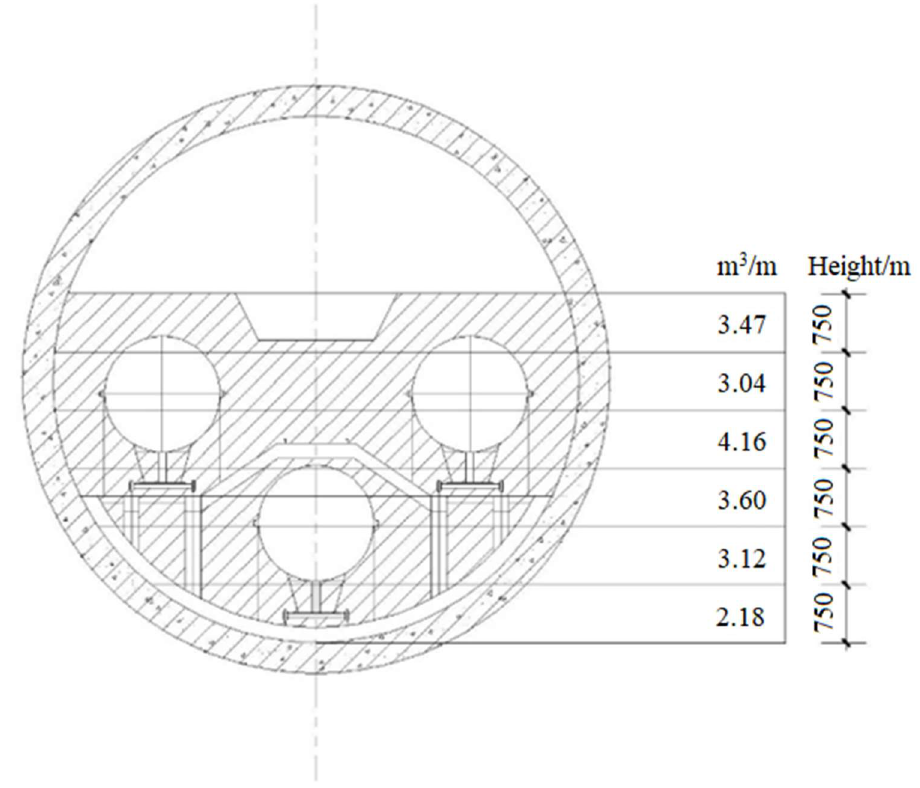
Figure 6. Schematic diagram of thickness of foamed concrete pouring layers.